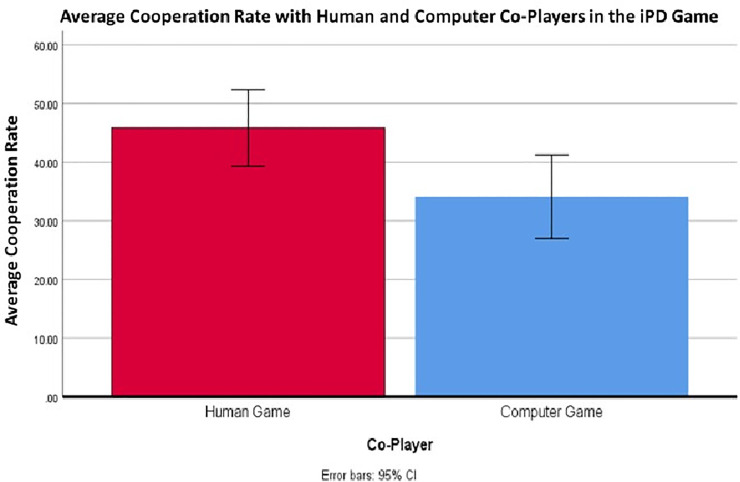
A graphical illustration of the participants’ average cooperation rate against “human” and computer co-players in the PD.Participants tended to cooperate more often against their human co-players suggesting that prosocial norms were at least partially taken into consideration during these games.